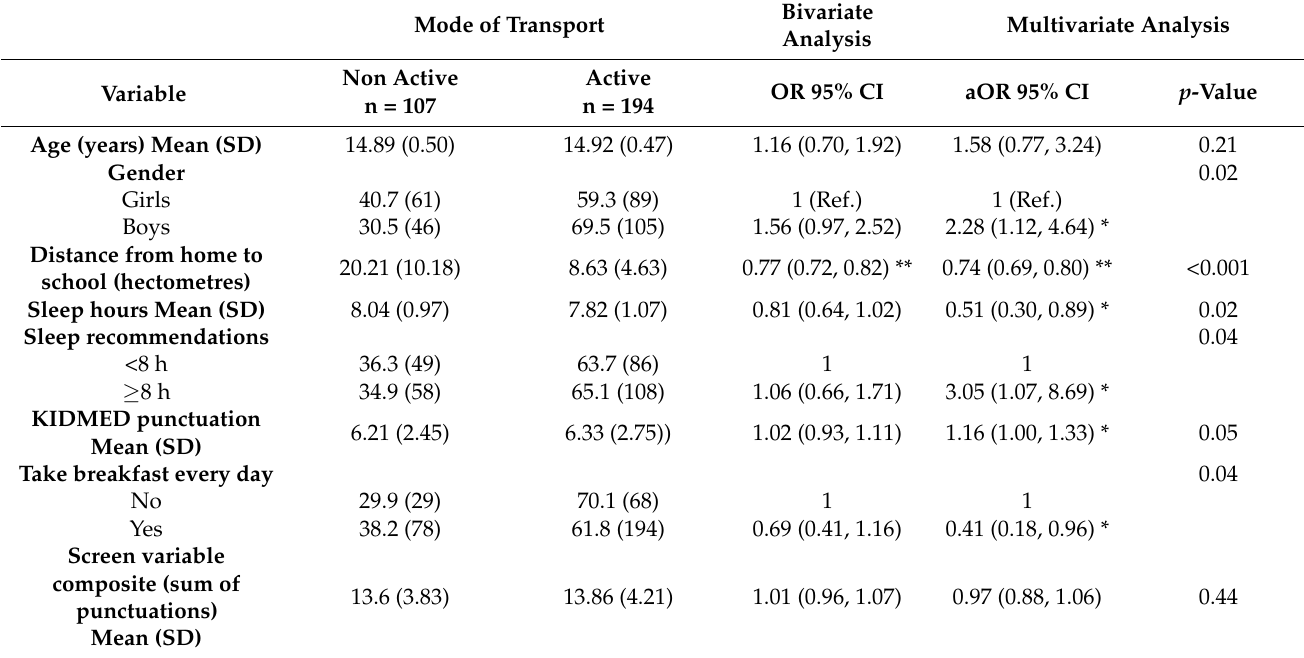
Table 3. Bivariate and multivariate associations between ACS and sociodemographic features and lifestyle behaviours (n =